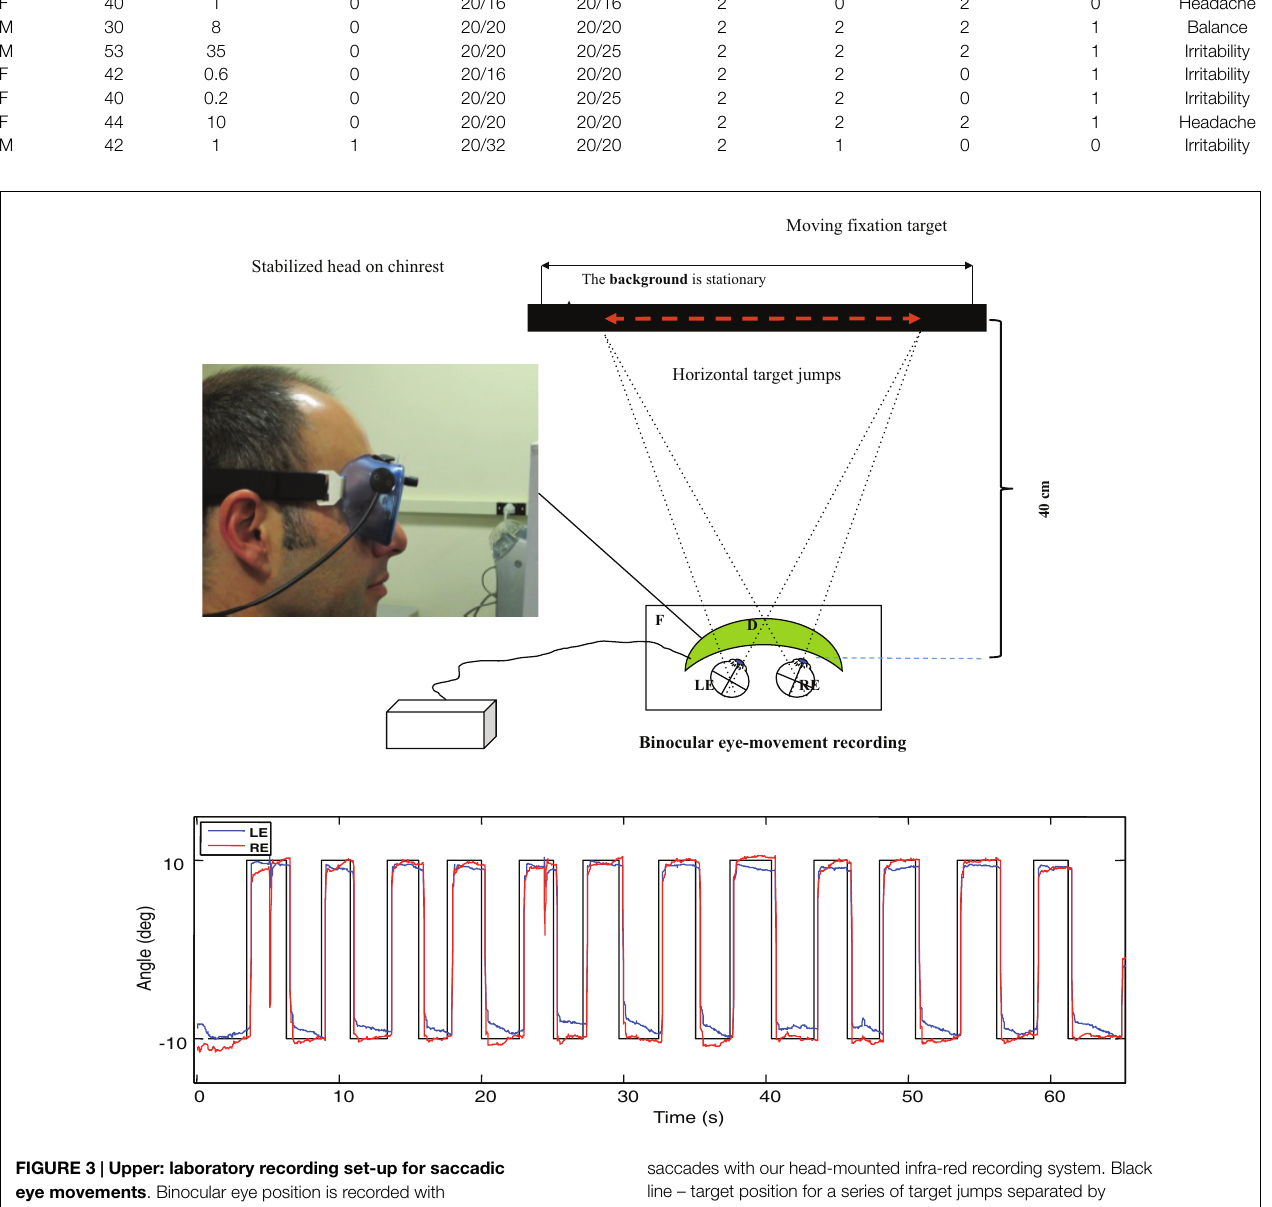
FIGURE 3 | Upper: laboratory recording set-up for saccadic eye movements . Binocular eye position is recorded with goggle-mounted infra-red limbal sensors; the target is presented on an LCD monitor. Lower: typical binocular eye-movement recording of